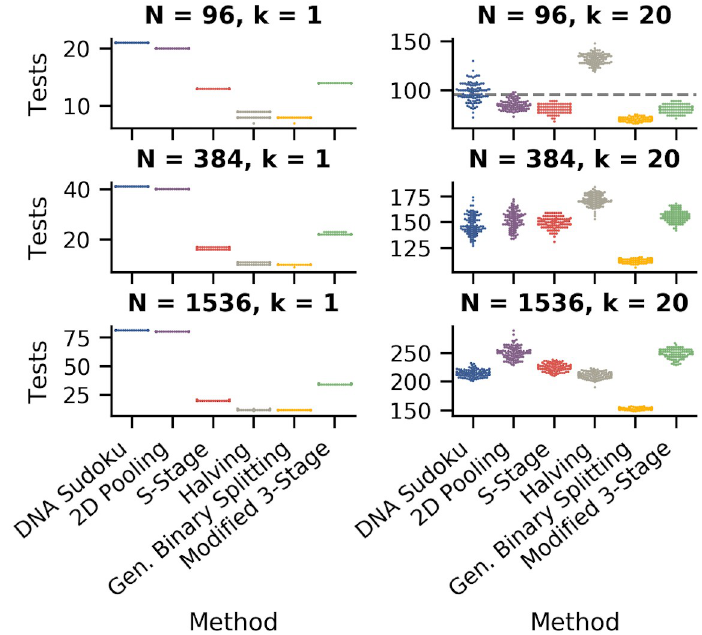
Fig 7. Comparison of the number of tests required for each pooling method. The swarm plots show the distribution of the number of tests required for each method (100 simulations each). The left column shows simulations with one positive sample and the right column shows simulations with 20 positive samples. The rows are different sample sizes from top to bottom: 96, 384, and 1,596. For the S-Stage, Modified 3-Stage, and General Binary Splitting approaches, the results shown are for simulations where the expected number of positive samples was the same as the true number of positives. For DNA Sudoku and 2D Pooling, the results shown are for simulations with parameters that resulted in the lowest average number of tests (DNA Sudoku: w = 2 when k = 1, and when k = 20, w = 3 for 96 samples and w = 4 for 384 and 1,536 samples; 2D Pooling: when k = 1, the grid sizes shown are 1x10x10 for 96 samples, 1x20x20 for 394 samples, and 1x40x40 for 1536 samples, and when k = 20 the grid sizes are 11x3x3 for 96 samples, 24x4x4 for 384 samples, and 96x4x4 for 1,536 samples).